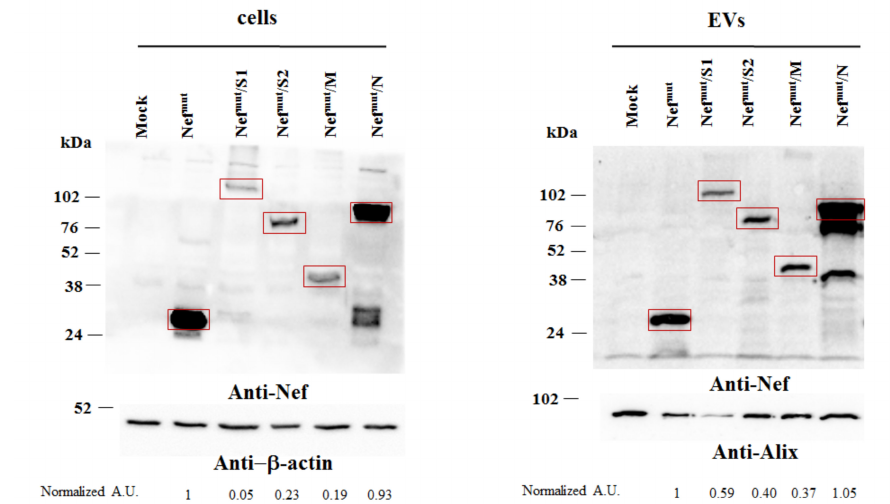
Figure 3. Detection of Nef mut /SARS-CoV-2 fusion products in transfected cells and extracellular vesicles (EVs). Western blot analysis of 30 µ g of lysates from HEK293T cells transfected with DNA vectors expressing Nef mut fused with either S1, S2, M, or N SARS-CoV-2 open reading frames (ORFs) (left panels). Equal volumes of buffer where purified EVs were resuspended after differential centrifugations of respective supernatants were also analyzed (right panels). As control, conditions from mock-transfected cells as well as cells transfected with a vector expressing Nef mut alone were included. Polyclonal anti-Nef Abs served to detect Nef mut -based products, while β -actin and Alix were revealed as markers for cell lysates and EVs, respectively. Relevant signals are highlighted. Molecular markers are given in kDa. Relative intensities of relevant signals after normalization with either β -actin (for cell lysates) or Alix (for EVs) signals were also reported as arbitrary units (A.U.), and considering the Nef mut conditions as reference samples. The results are representative of four independent experiments (Figure